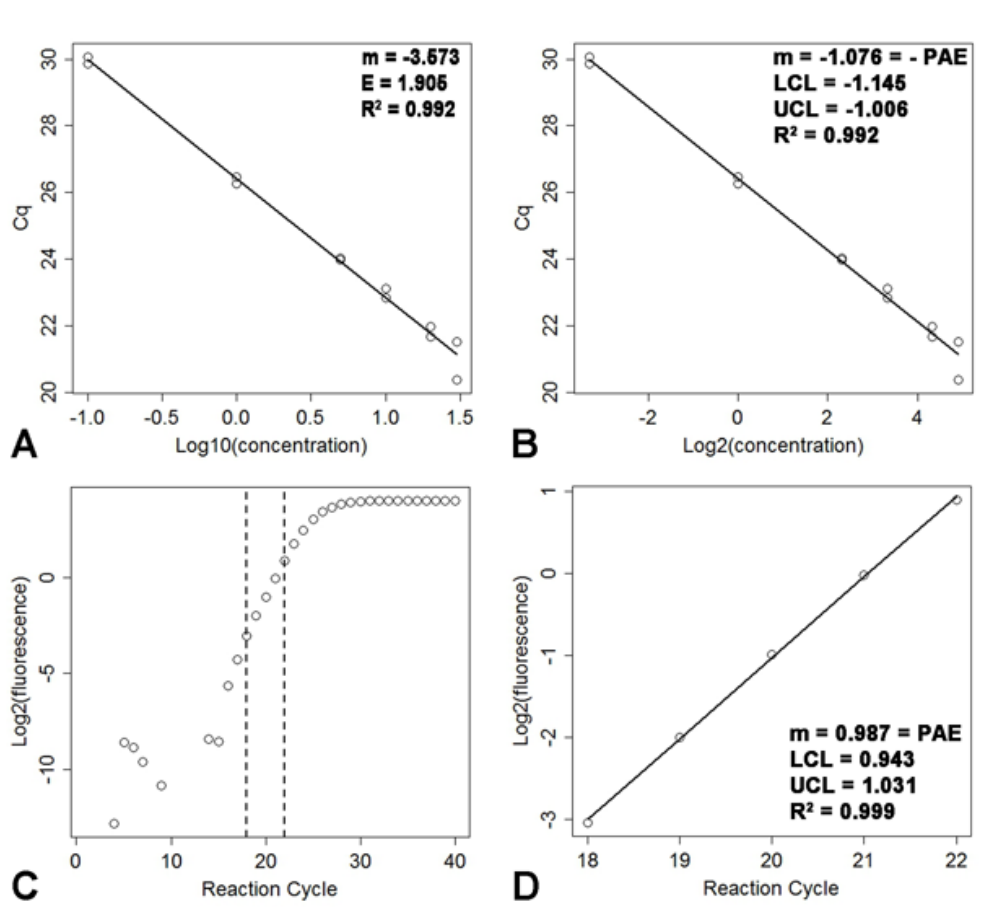
FIGURE 2. Various methods of estimating E and PAE. (A) Estimation of E from a dilution series using the log (cDNA concentration) method. E is estimated using Eq. 8 (see text). (B) 10 Estimation of PAE from the same dilution series shown in panel A using the log concentration) approach. LCL = lower 95% confidence limit of the slope and UCL = upper 95% confidence limit of the slope. Note that the estimate of PAE is marginally greater than 1 at the 0.05 level, indicating that this method has overestimated the true value of PAE. (C) A log transformation of the amplification plot shown in Fig. 1. The exponential phase of the reaction consists of cycles 18 through 22 as indicated by the dashed vertical lines. (D) Estimation of PAE using the exponential phase cycles highlighted in panel C. Note that the estimate of PAE is not significantly different from 1 at the 0.05